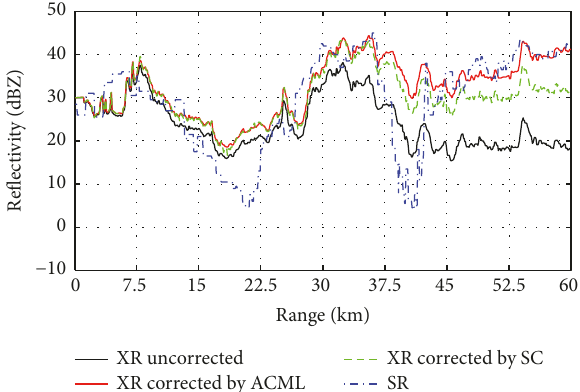
Figure 10: The range profiles of SR reflectivity and XR reflectivity before and after correction along the ray of azimuth 236 ∘ in Figure